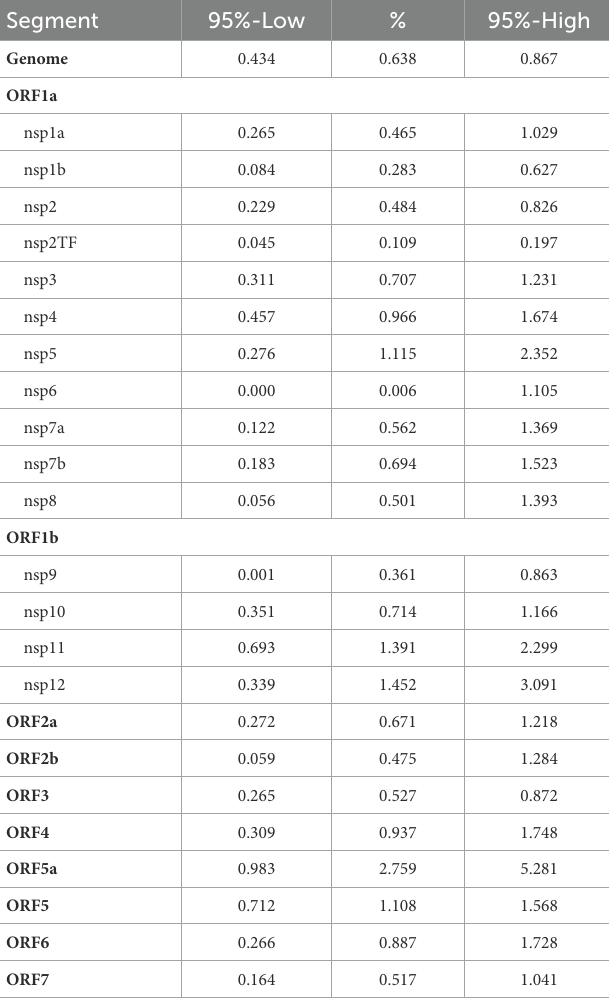
TABLE 2 Yearly drift and 95% confidence interval per segment of the viral